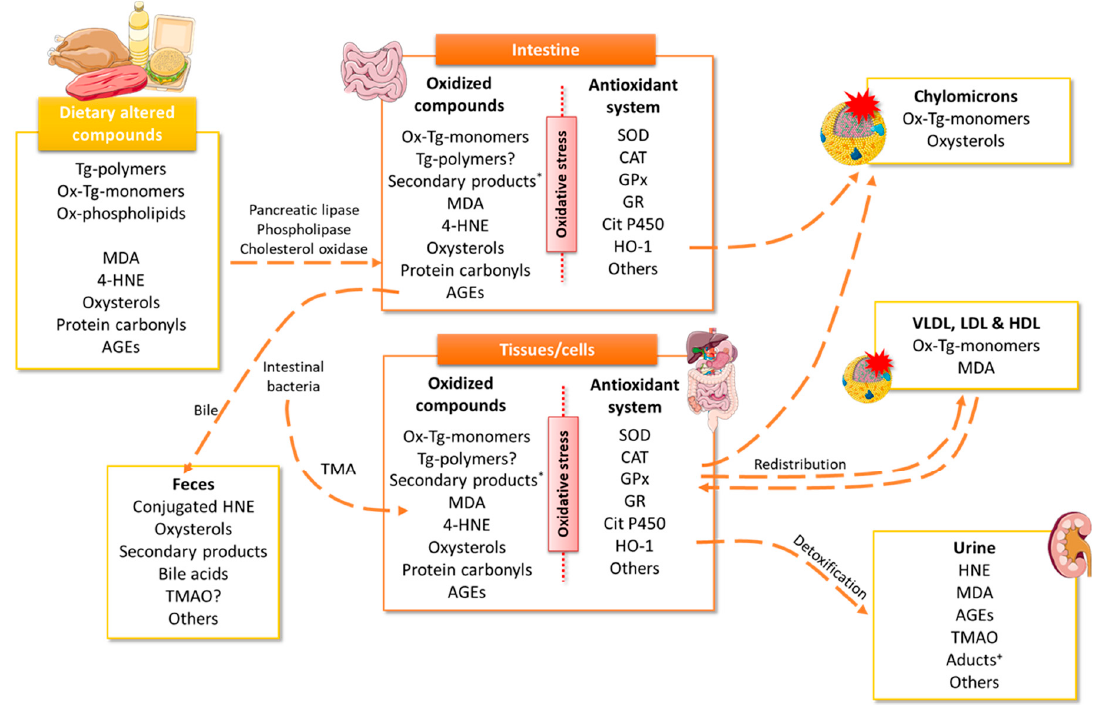
Figure 1. Possible metabolic fate of dietary altered compounds. The scheme illustrates the different body pathways for eliminating those altered products observed. *secondary products included short- or medium-chain alkyl group, carbonyl, hydroxyl, aldehyde, ester, epoxy, carboxyl, etc. + Adducts include HNE adducts and HNE conjugates. 4-HNE, 4-hydroxy-nonenal; AGEs, advanced glycation end-products; CAT, catalase; GPx, glutathione peroxidase; GR, glutathione reductase; HDL, high-density lipoproteins; HNE, hydroxynonenal; HO, heme oxygenase; LDL, low-density lipoproteins; MDA, malondialdehyde; Ox, oxidized; SOD, superoxide dismutase; Tg, triglycerides; TMAO, trimethylamine N-Oxide; VLDL, very low density lipoproteins.